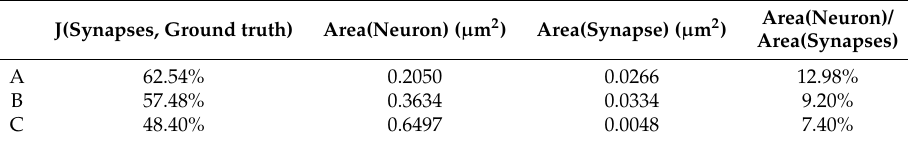
Table 4. Statistics of MSBs in Figure